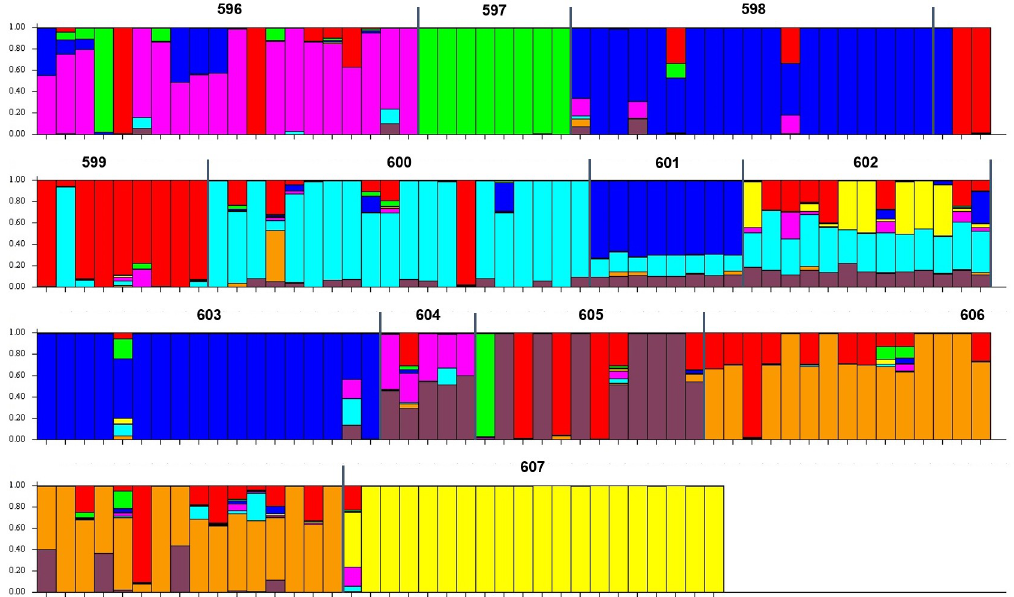
Fig 3. Bayesian model-based analysis using STRUCTURE software ( K =